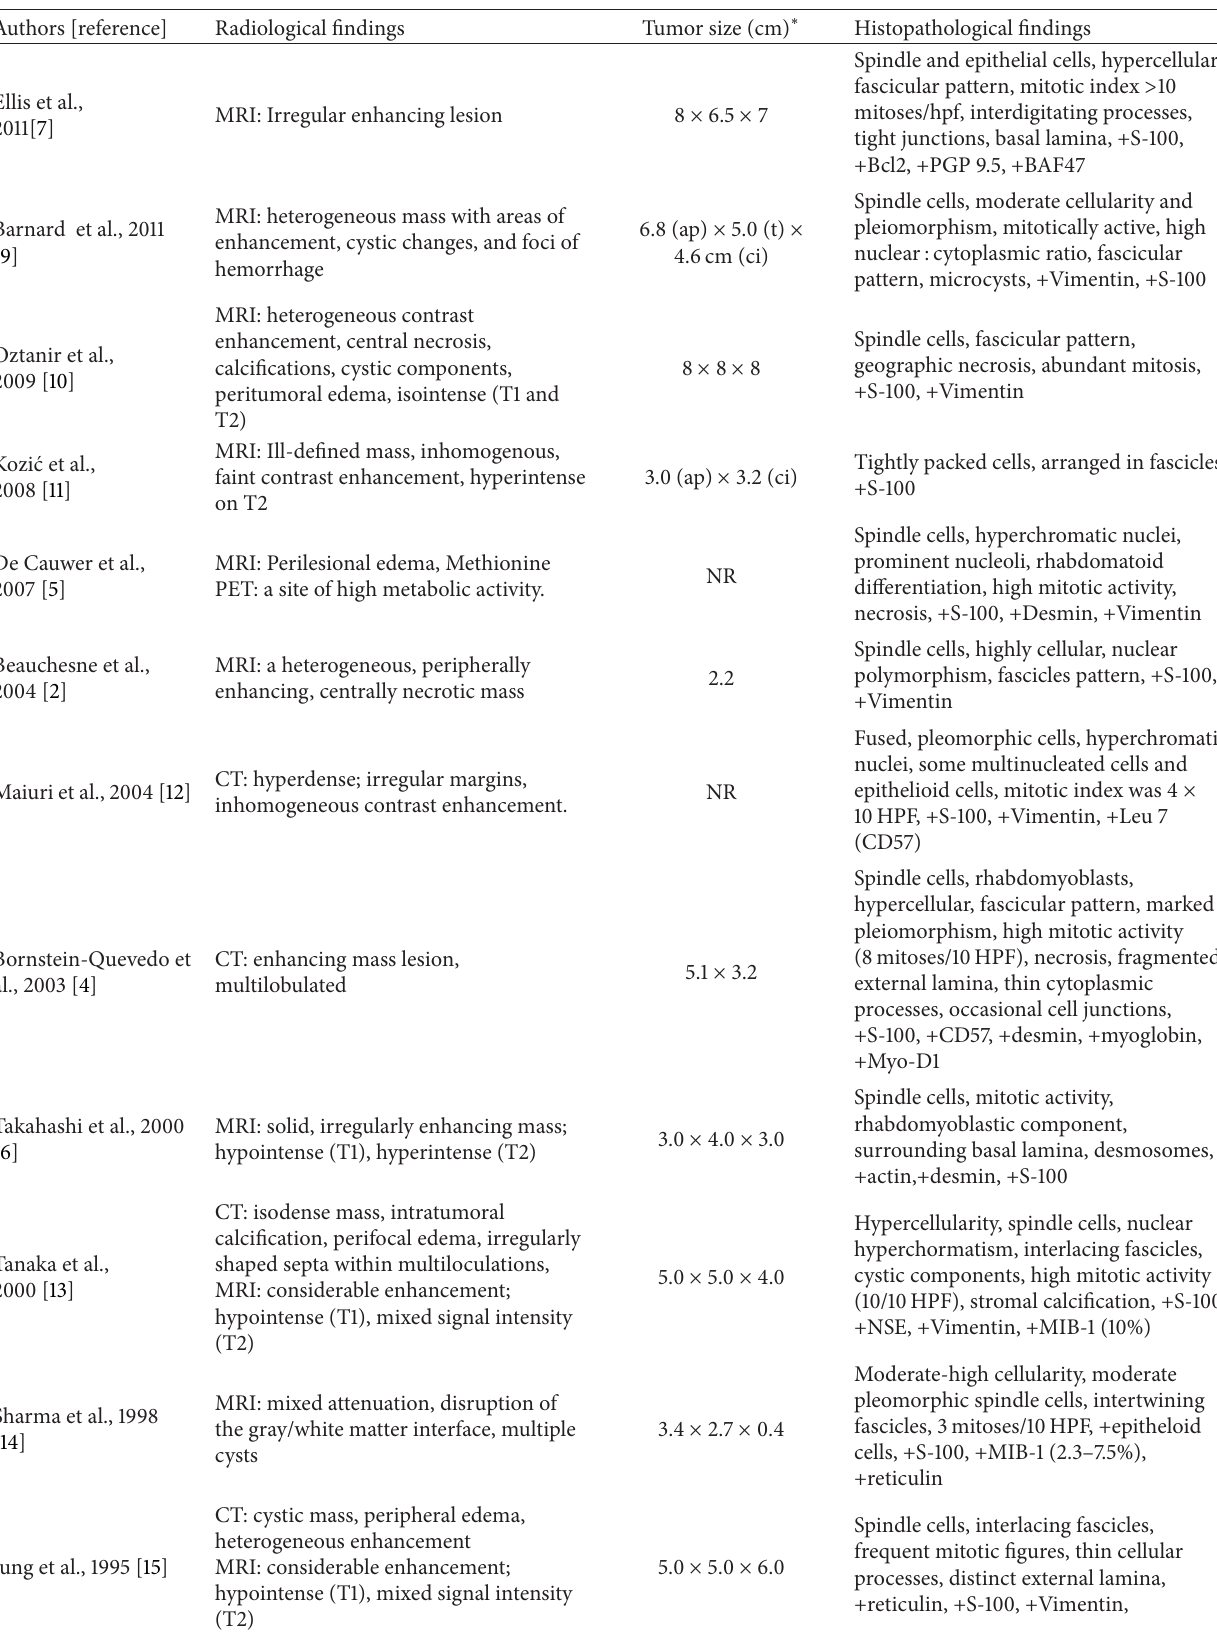
Table 2: Radiographic and histological features in 15 reported cases of